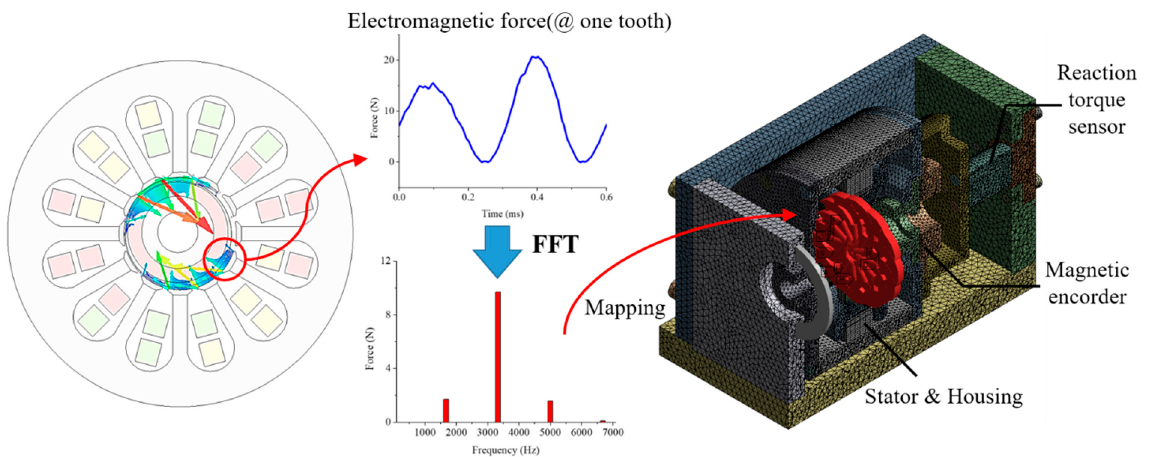
Figure 8. Concept of forced vibration (electromagnetic-structural one-way coupled) analysis.